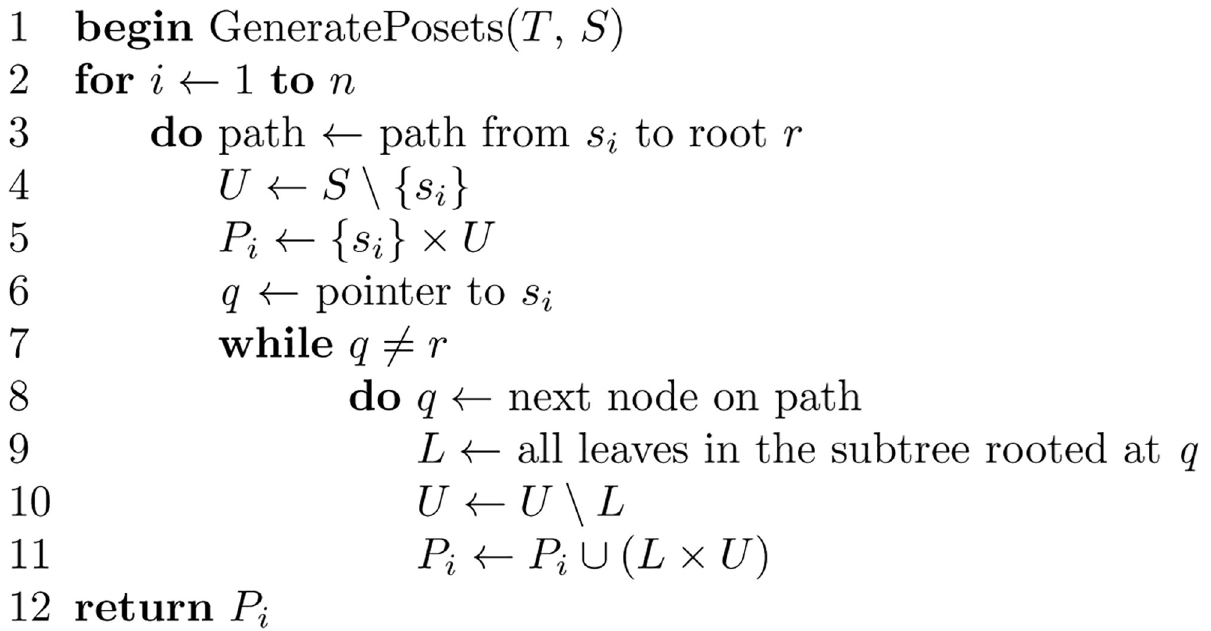
Fig 23. Algorithm to generate a set of posets P from an S -tree T